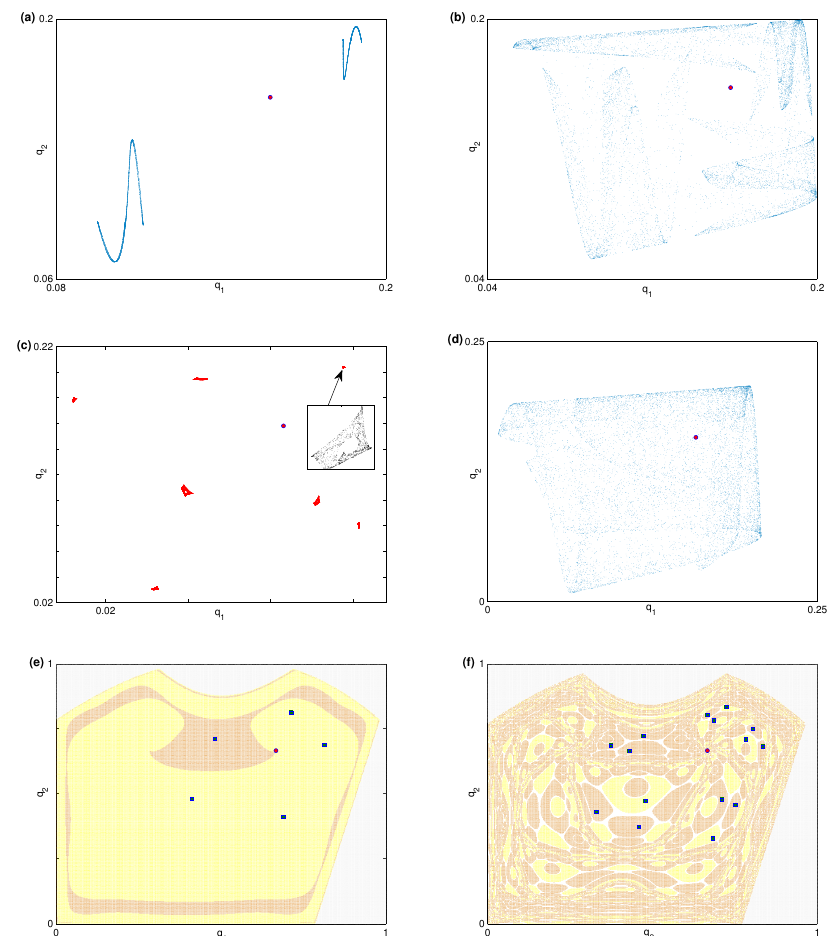
Figure 5. ( a ) The phase plane of two unconnected chaotic attractors at k = 7.9. ( b ) The phase plane of a chaotic attractor at k = 8.2. ( c ) The phase plane of seven unconnected chaotic attractors at k = 8.566. ( d ) The phase plane of a chaotic attractor at k = 8.86. ( e ) The basin of attraction of period-5 cycle at k = 1.75. ( f ) The basin of attraction of period-15 cycle at k = 1.98. The data set is a = 2.3, b = − 0.1 and c = 2 for ( a – d ). The data set is a = 2, b = − 0.5 and c = 1 for ( e , f